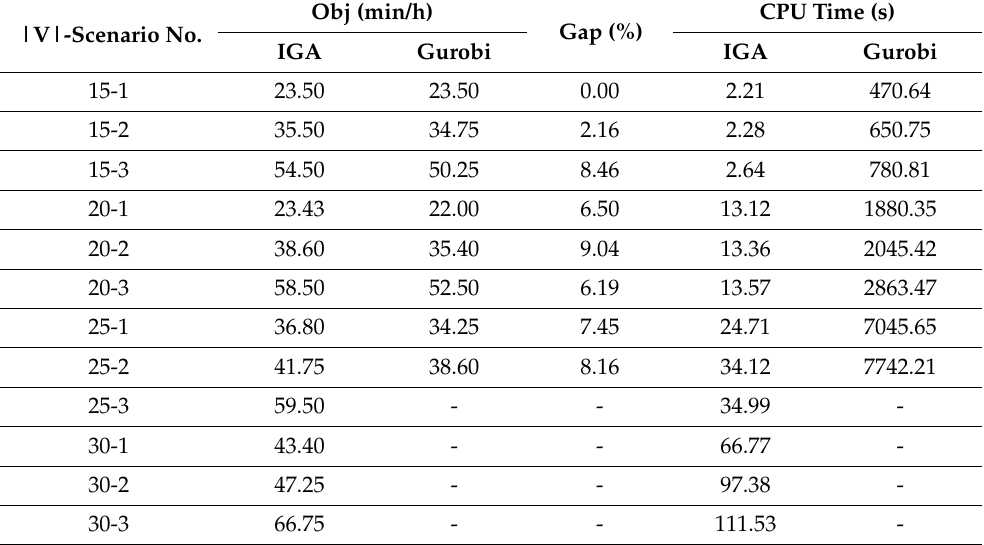
Table 3. Comparison results with commercial